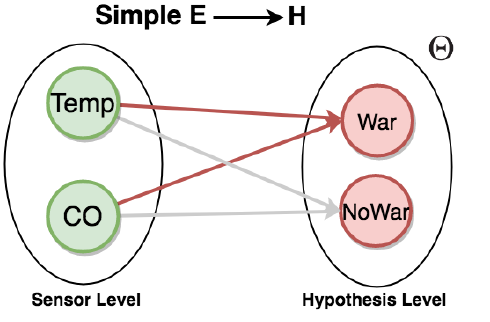
Figure 7. Graph for representing warning